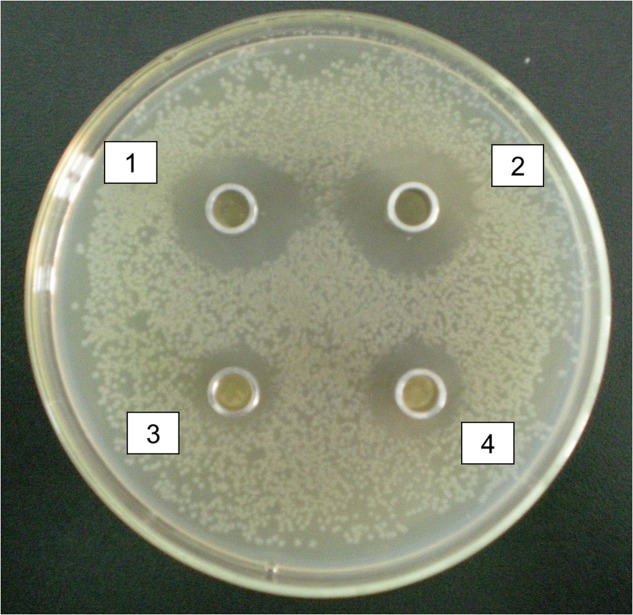
Antibacterial characters of selected isolated Lactic acid bacteria. 1 and 2 were antibacterial effect of Lactococcus raffinolactis and Lactobacillus agilis on Escherichia coli with obvious inhibition zone from 1.9 to 2.2 cm. 3 and 4 were antibacterial effect of Lactobacillus aviaries and Lactobacillus acidophilus on E. coli with un-obvious inhibition zone from 0.8 to 1.1 cm.